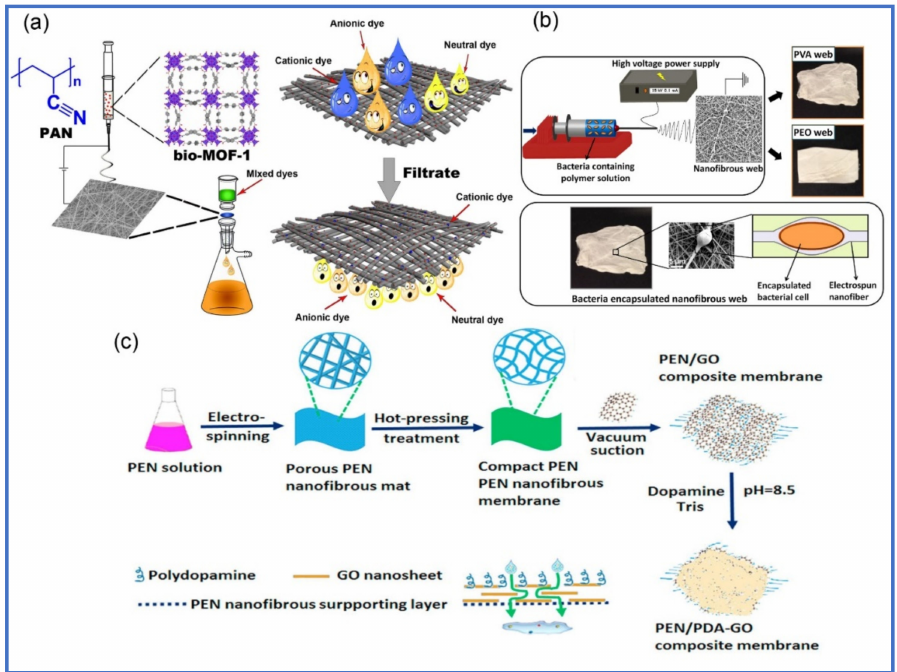
Figure 8. ( a ) Fabrication of bio-MOF/PAN nanofiber composite for removal MB dye [174], Copyright © (2020) Elsevier ( b ) In- corporation bacteria into PVA/PEO nanofibers for removal MB dye [175], Copyright © (2020) Elsevier and ( c ) Fabrication of PAEN/GO-PDA nanofiber composite for removal DB-14 dye [173], Copyright © (2020)